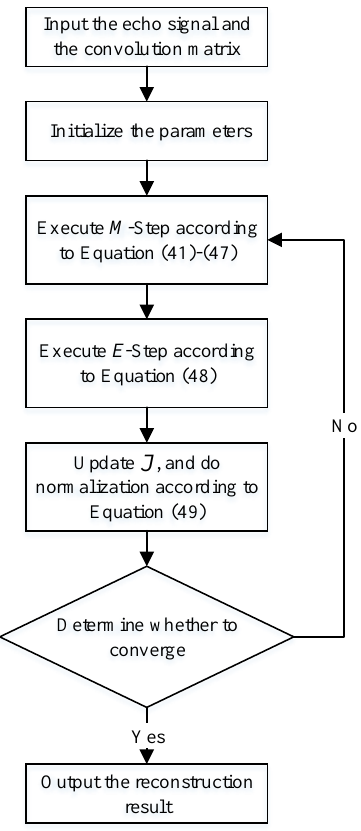
Figure 4. The flowchart of the multi-prior Bayesian